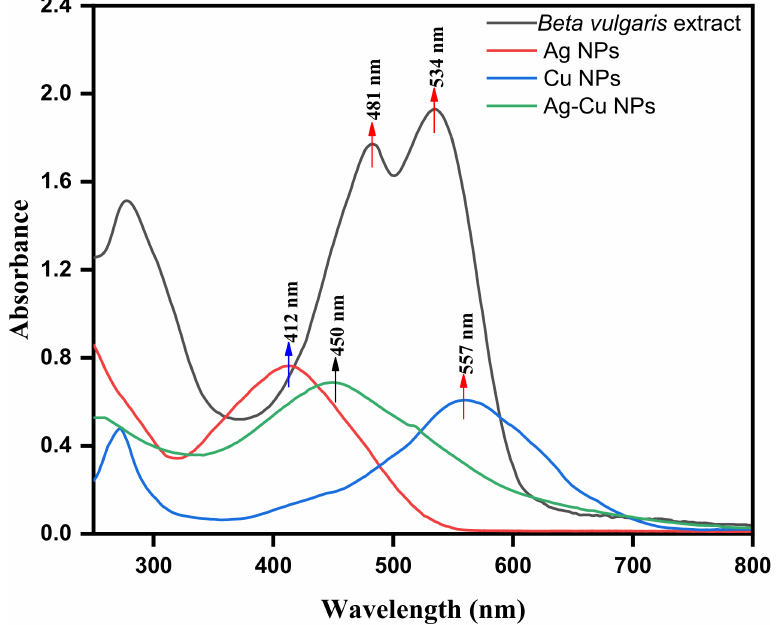
Figure 3. UV–Visible spectra of Beta vulgaris extract, Ag NPs, CuNPs and Ag-Cu bimetallic